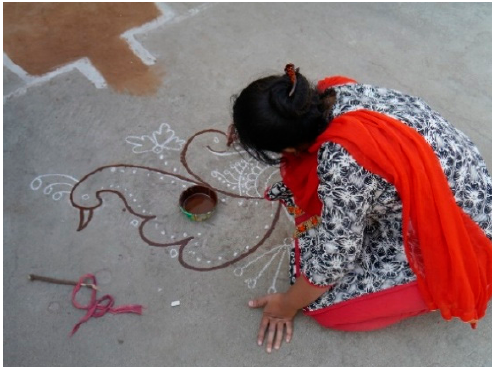
Figure 4. Young woman colouring her peacock rangoli design at the doorstep of her house, Badi 2017 (picture by author).